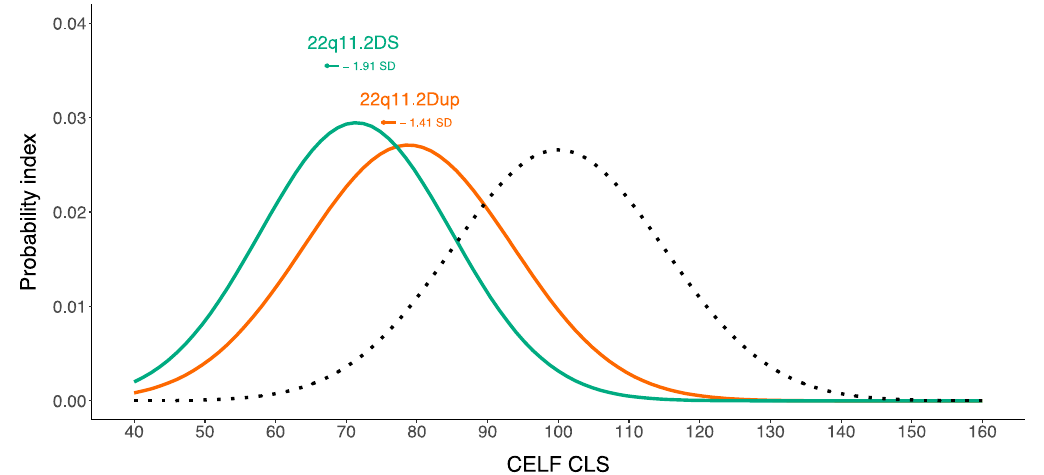
Figure 3. Normative distributions of CELF Core Language Scores across groups (22q11.2DS and 22q11.2Dup). SD, standard deviation. The dashed line illustrates the normative distribution of the norm group (mean = 100, SD = 15). SD shifts are calculated in relation to the normative sample.